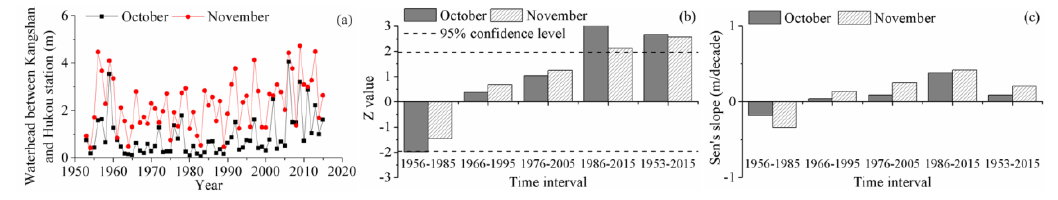
Figure 8. Change features of waterhead between Kangshan and Hukou station: the sub-figures labeled (a–c) display annual values, Z values, and Sen’s slopes, respectively.